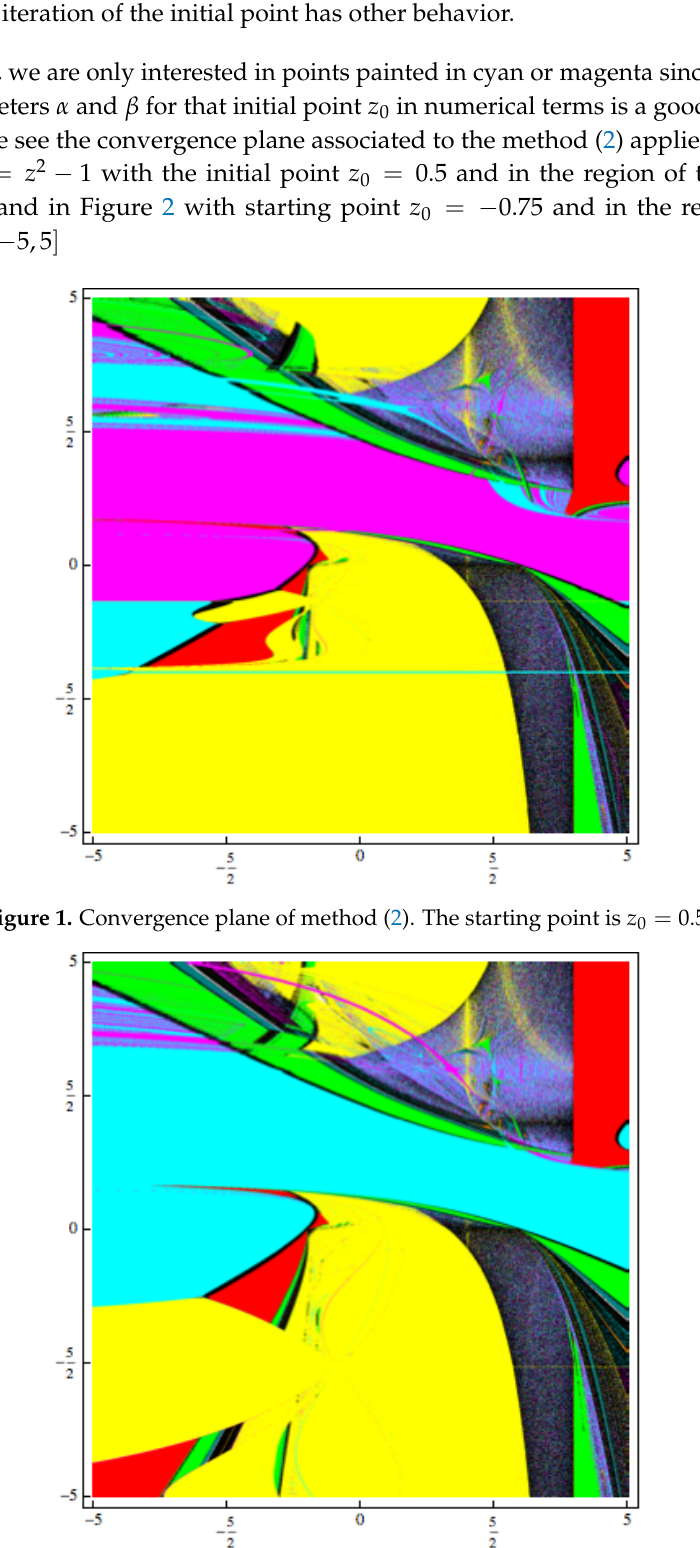
Figure 2. Convergence plane of method (2). The starting point is z 0 =